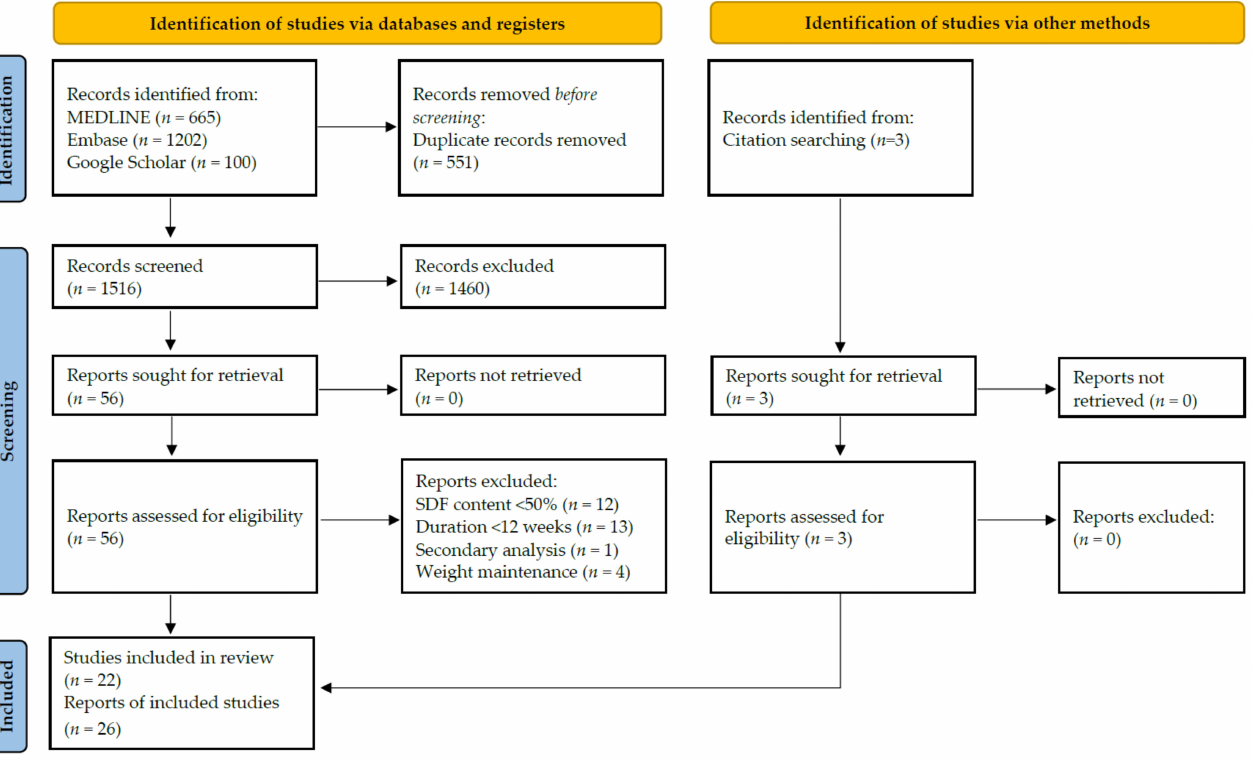
Figure 1. PRISMA flow chart according to [1] elaborating on the selection process of the 22 included studies. SDF = soluble dietary